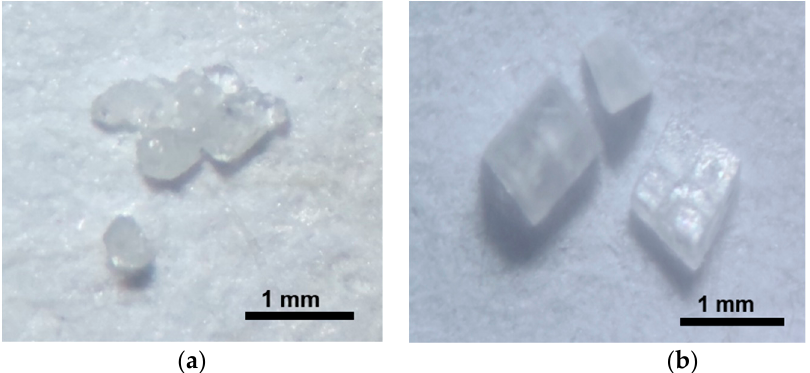
Figure 1. OM image of ( a ) [NH 4 ][Mg(HCOO) 3 ] and ( b ) [(CH 3 ) 2 NH 2 ][Mg(HCOO) 3 ] crystals.